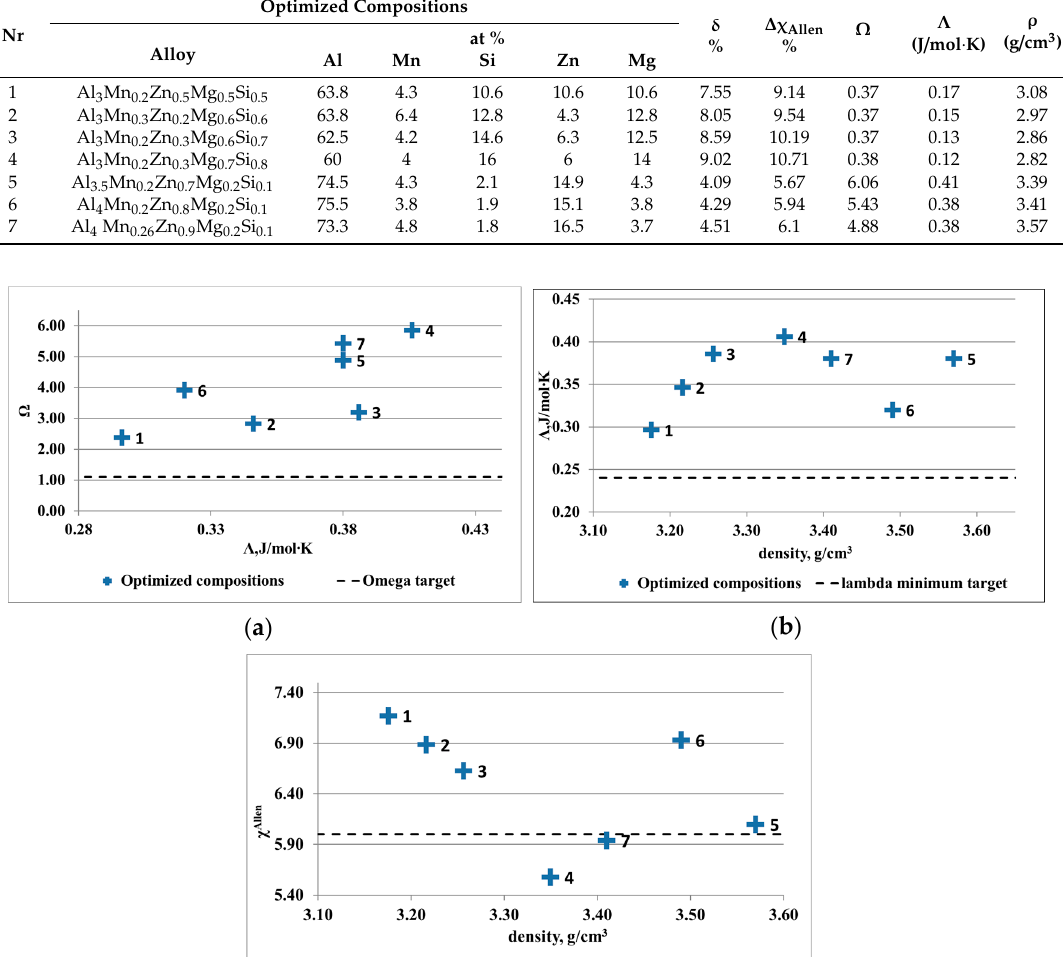
Table 2. Multiobjective optimization results for Al-Cu-Si-Zn-Mg system